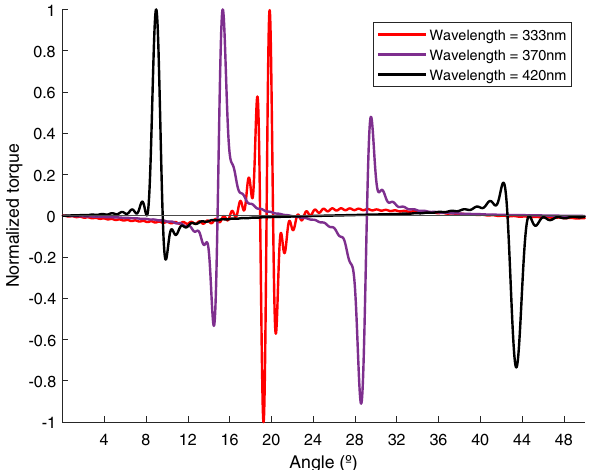
Figure 9. Normalized torque versus angle for (cid:31) equal to 333 nm (red line), 370 nm (purple line) and 420 nm (black